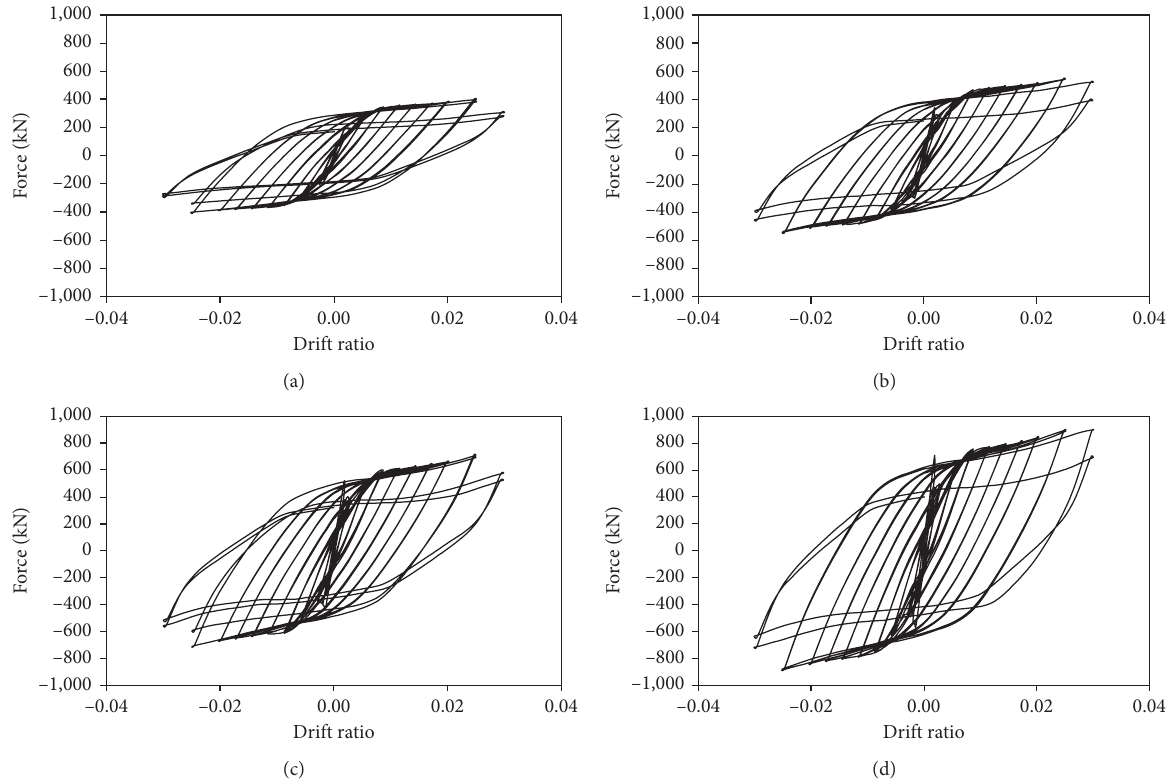
Figure 17: Hysteresis curves of beam-only-connected V-CSPSW at different panel aspect ratios. (a) Ar � 1.00. (b) Ar � 1.67. (c) Ar � 2.33. (d) Ar �